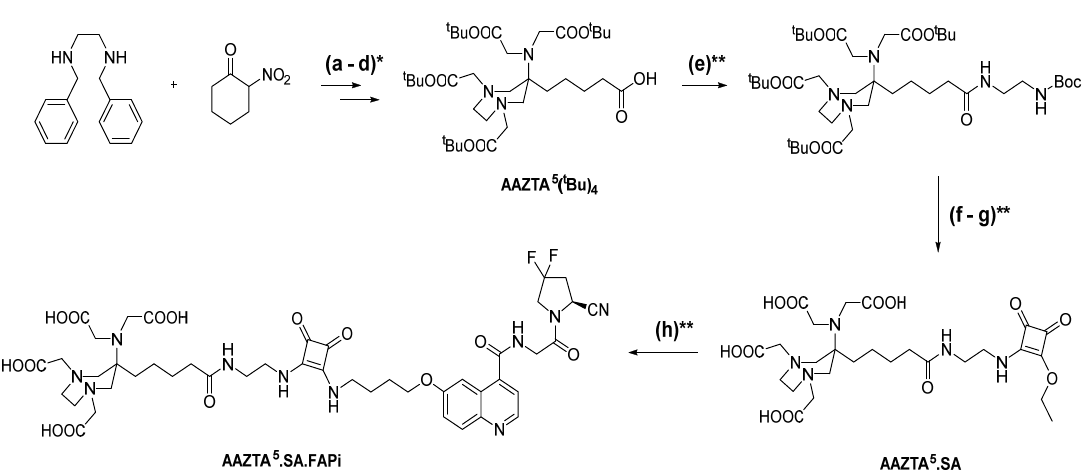
Figure 1. Synthesis of AAZTA 5 .SA.FAPi via AAZTA 5 ( t Bu) 4 and AAZTA 5 .SA: ( a ) 2-nitrocyclohexanone, Amberlyst A21, paraformaldehyde, methanol, 80 °C, 16 h; ( b ) palladium hydroxide/C, acetic acid, hydrogen, ethanol, 25 °C, 16 h; ( c ) tert- butyl bromoacetate, potassium carbonate, potassium iodide, acetonitrile, 40 °C, 48-72 h; ( d ) 1 M lithium hydroxide, 1,4- dioxane/water (2:1), 25 °C, 16 h; ( e ) N-Boc-ethylenediamine, HATU, HOBt, DIPEA, acetonitrile, 25 °C, 16 h; ( f ) dichloromethane/TFA (80:20)%, 25 °C, 7 h; ( g ) 3,4-diethoxycyclobut-3-ene-1,2-dione, 0.5 M phosphate buffer pH = 7, 25 °C, 16 h; ( h ) NH 2 -UAMC1110, 0.5 M phosphate buffer pH = 9, 25 °C, 16 h; ( * ) as reported [44,45]; ( ** ) as reported [24] . DOTA.SA.FAPi was synthesized as previously described [24].